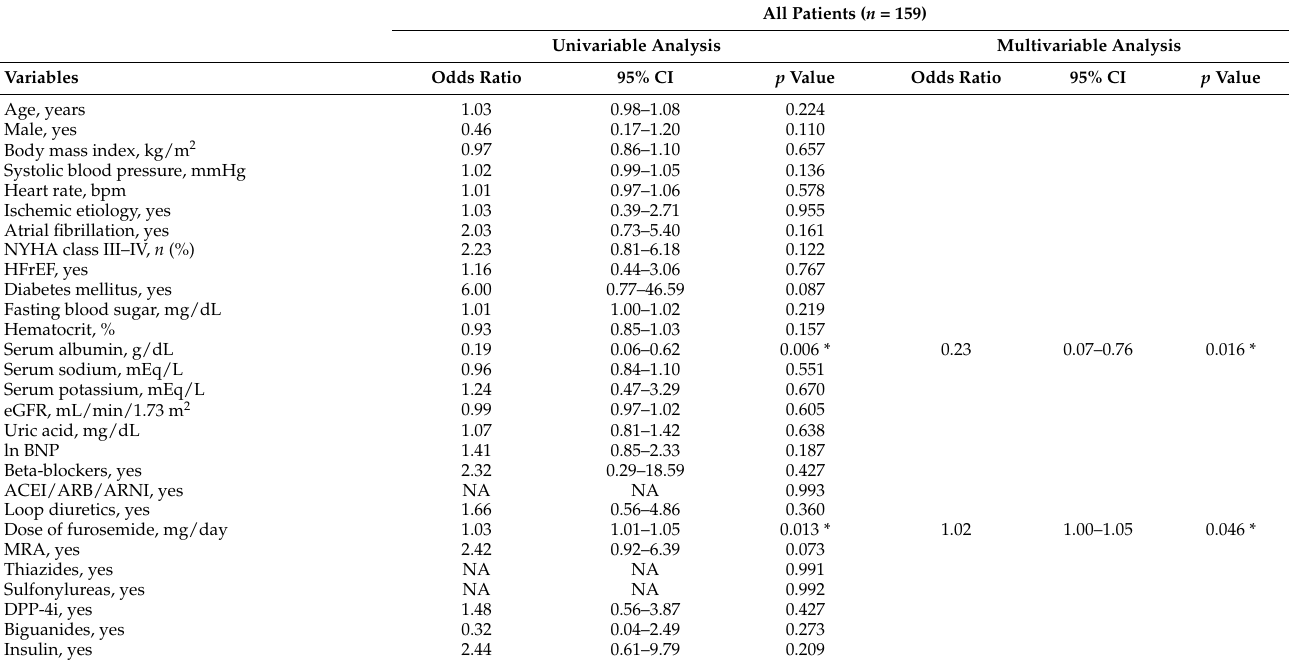
Table 2. Variables associated with discontinuation of SGLT2